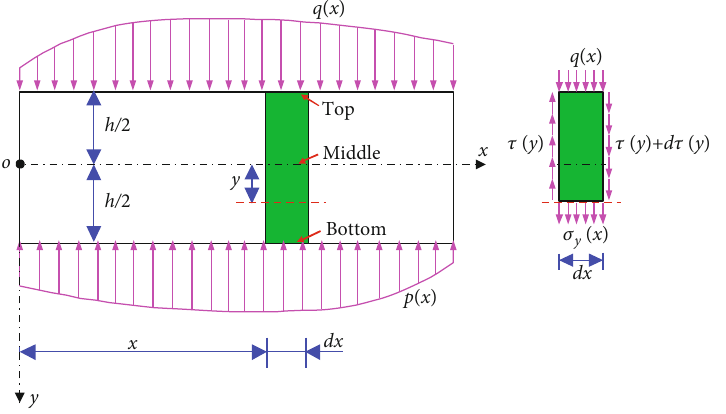
Figure 11: Force analysis diagram of beam microelement.